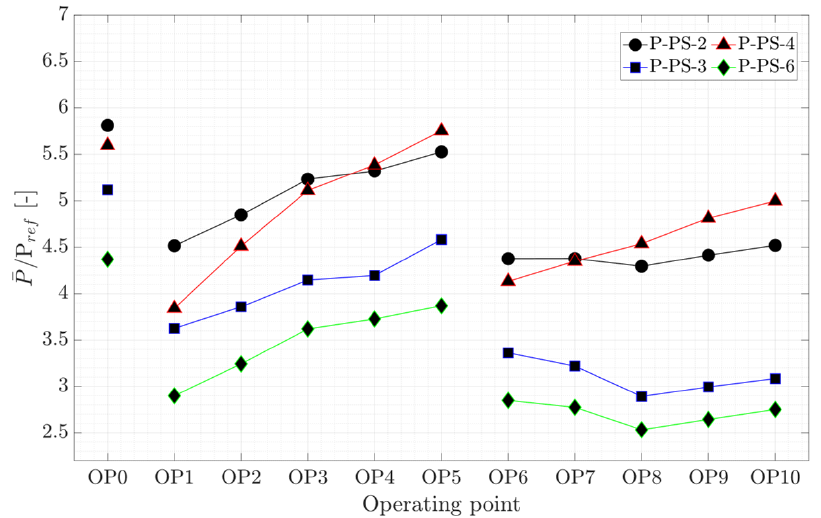
Figure 5. Normalized average pressure of four pressure transducers on the runner blade at OP0–OP10.